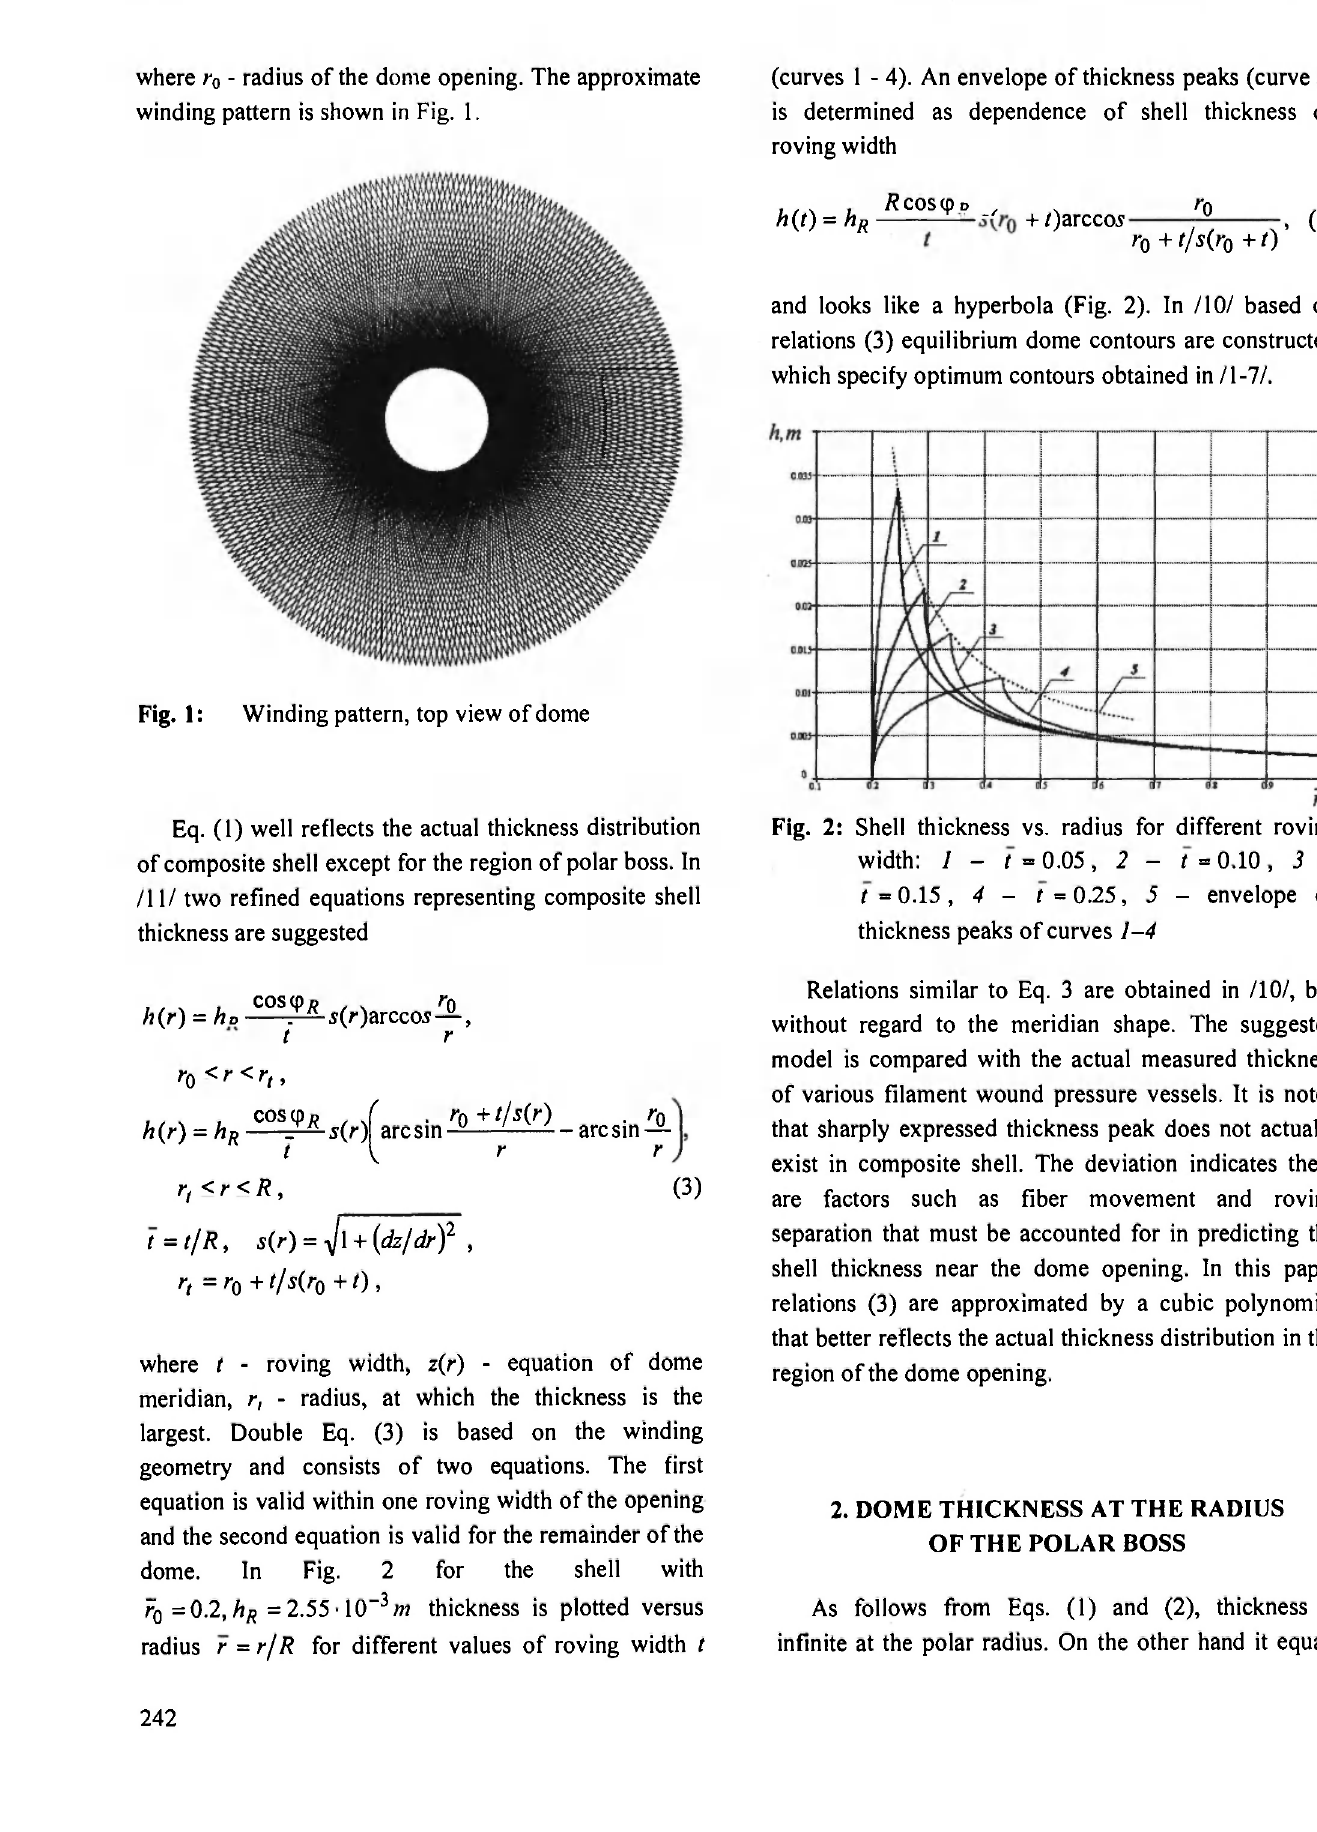
Fig. 1: Winding pattern, top view of dome